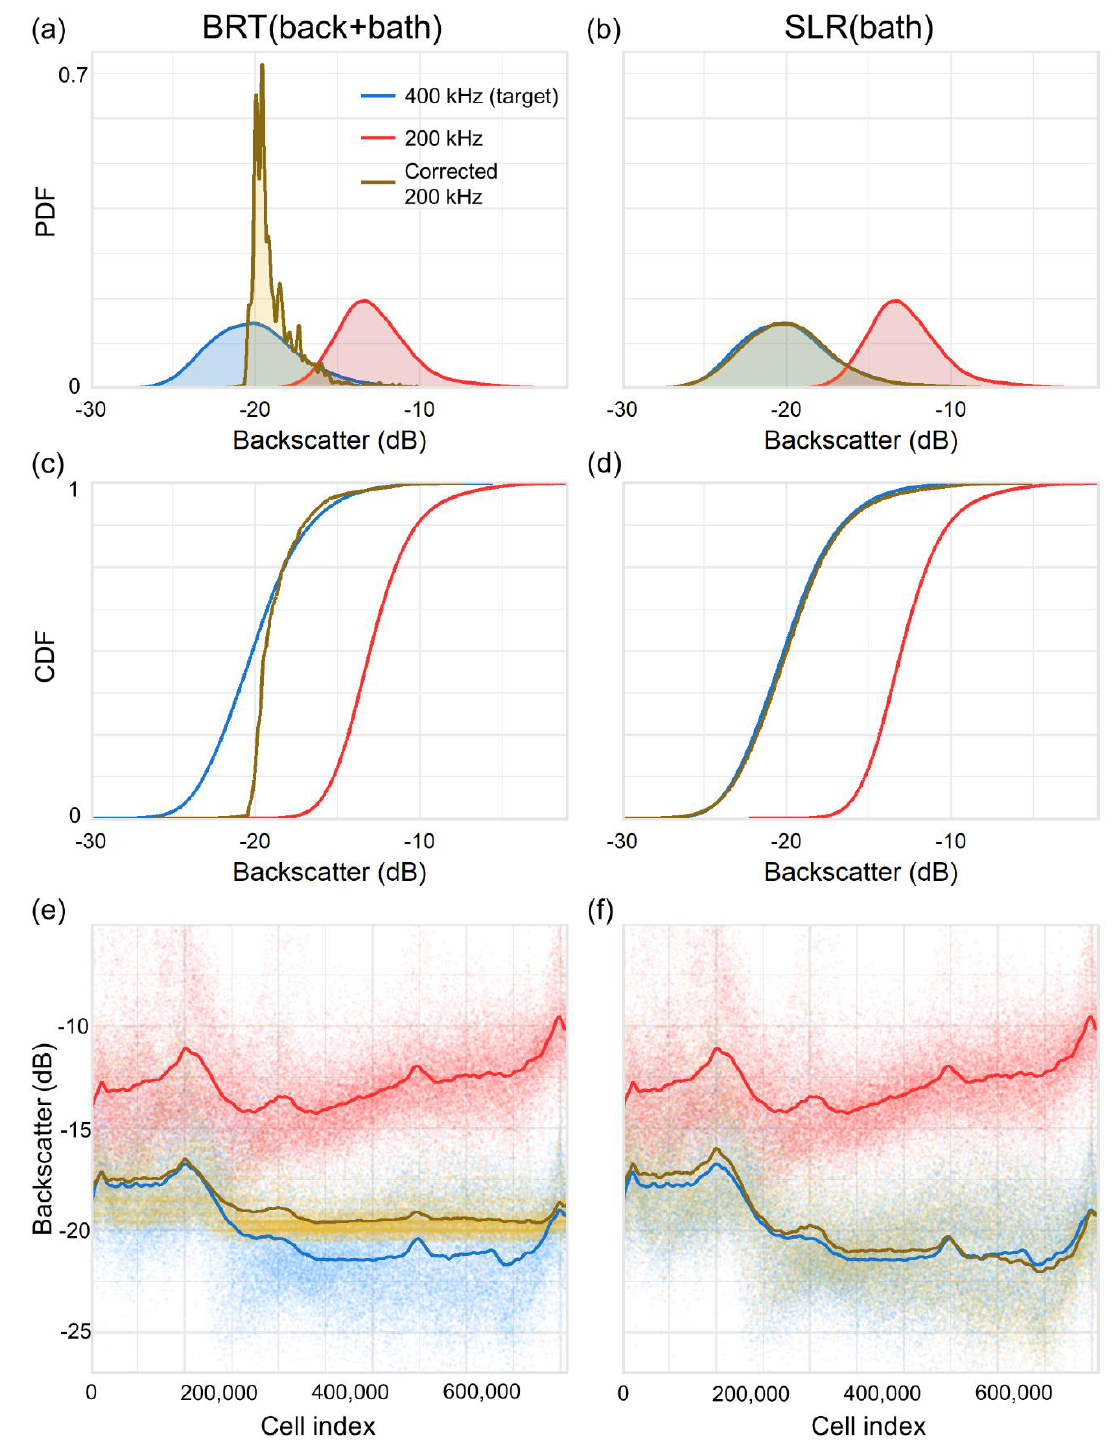
Figure 12. Patricia Bay 200 and 400 kHz test data comparison. PDFs of ( a ) BRT(back + bath), and ( b ) SLR(bath) shifts; CDFs of ( c ) BRT(back + bath), and ( d ) SLR(bath) shifts; distribution of backscatter values with first order LOESS curves for ( e ) BRT(back + bath), and ( f ) SLR(bath) shifts, plotted by cell index on the x -axis, in which the rasters are read (north to south).